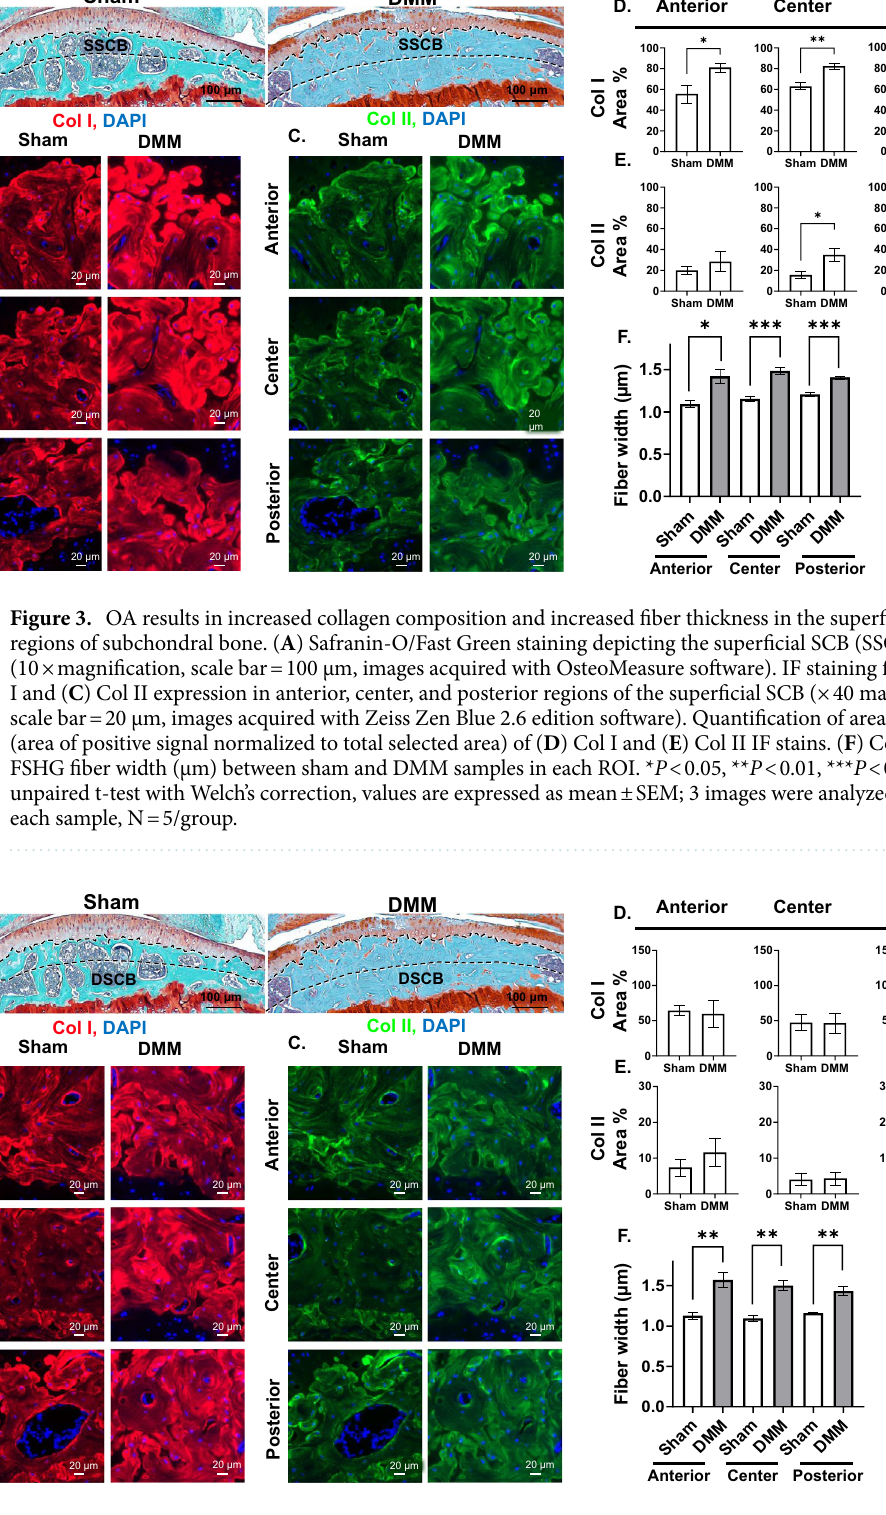
Figure 4. OA results in increased fiber thickness in the deep regions of subchondral bone. ( A ) Safranin-O/Fast Green staining depicting the deep SCB (DSCB) (× 10 magnification, scale bar = 100 μm, images acquired with OsteoMeasure software). IF staining for ( B ) Col I and ( C ) Col II expression in anterior, center, and posterior regions of deep SCB (× 40 magnification, scale bar = 20 μm, images acquired with Zeiss Zen Blue 2.6 edition software). Quantification of area percentage (area of positive signal normalized to total selected area) of ( D ) Col I and ( E ) Col II IF stains. ( F ) Comparison of FSHG fiber width (μm) between sham and DMM samples in each ROI. ** P < 0.01 using unpaired t-test with Welch’s correction, values are expressed as mean ± SEM; 3 images were analyzed per ROI in each sample, N =